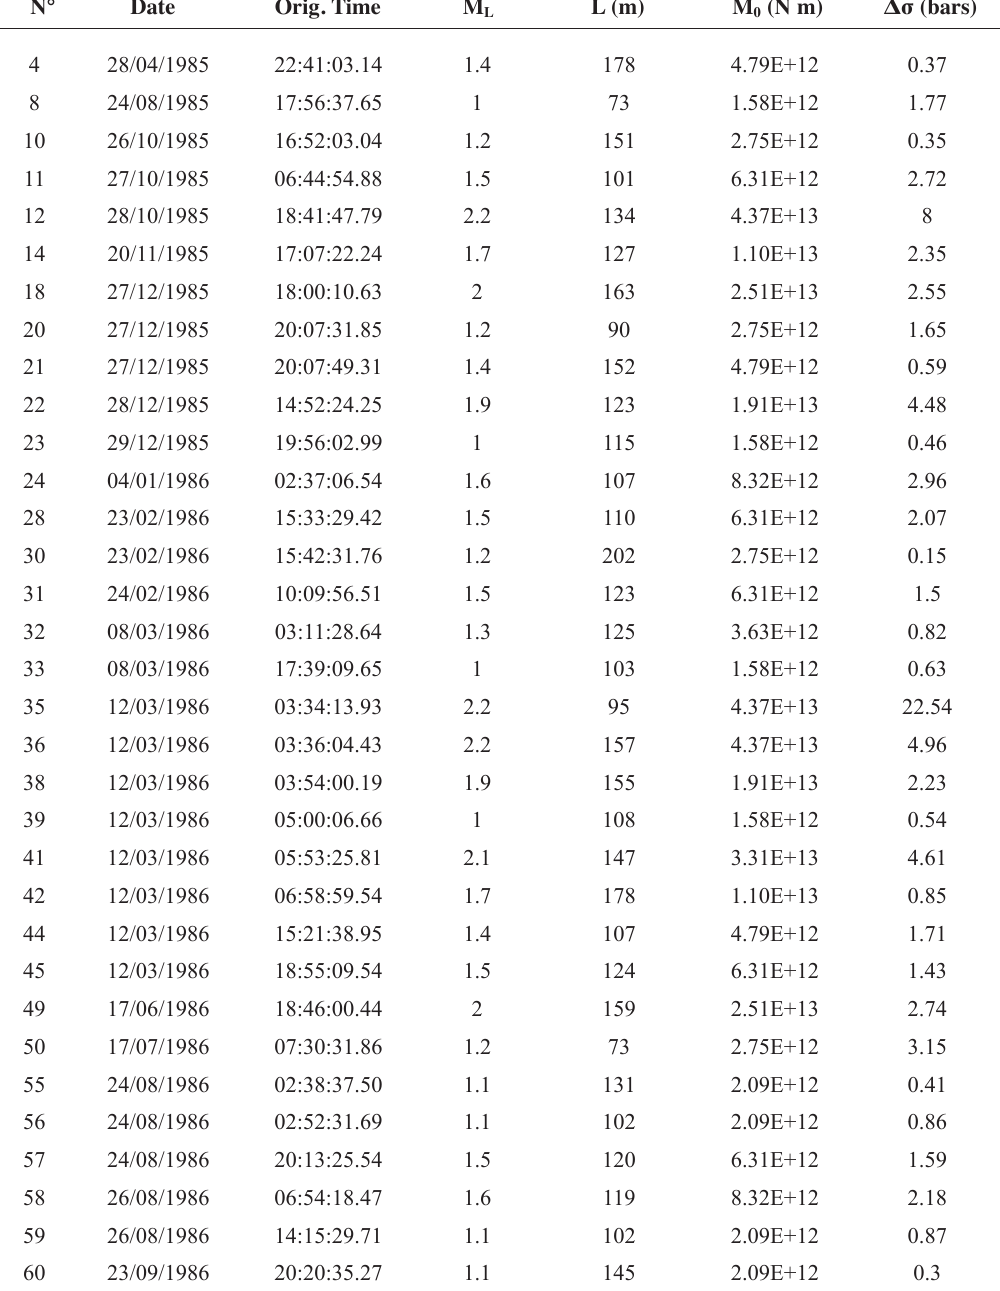
Table V. Source parameters of the analysed